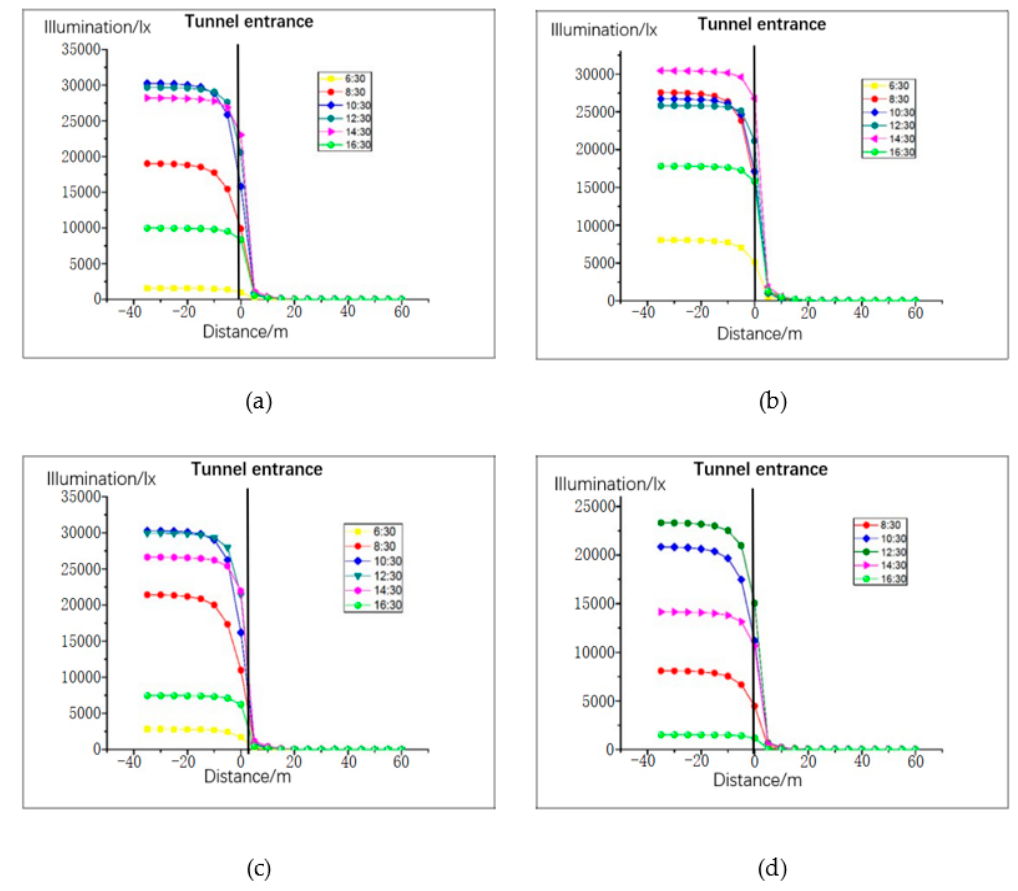
Figure 6. Road illumination for mixed weather pattern: ( a ) vernal equinox, ( b ) summer solstice, ( c ) autumn equinox, and ( d ) winter solstice.